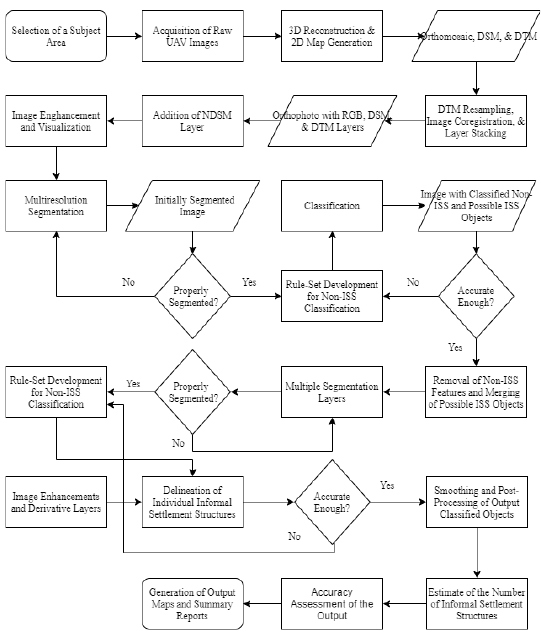
Figure 1. Flowchart of the